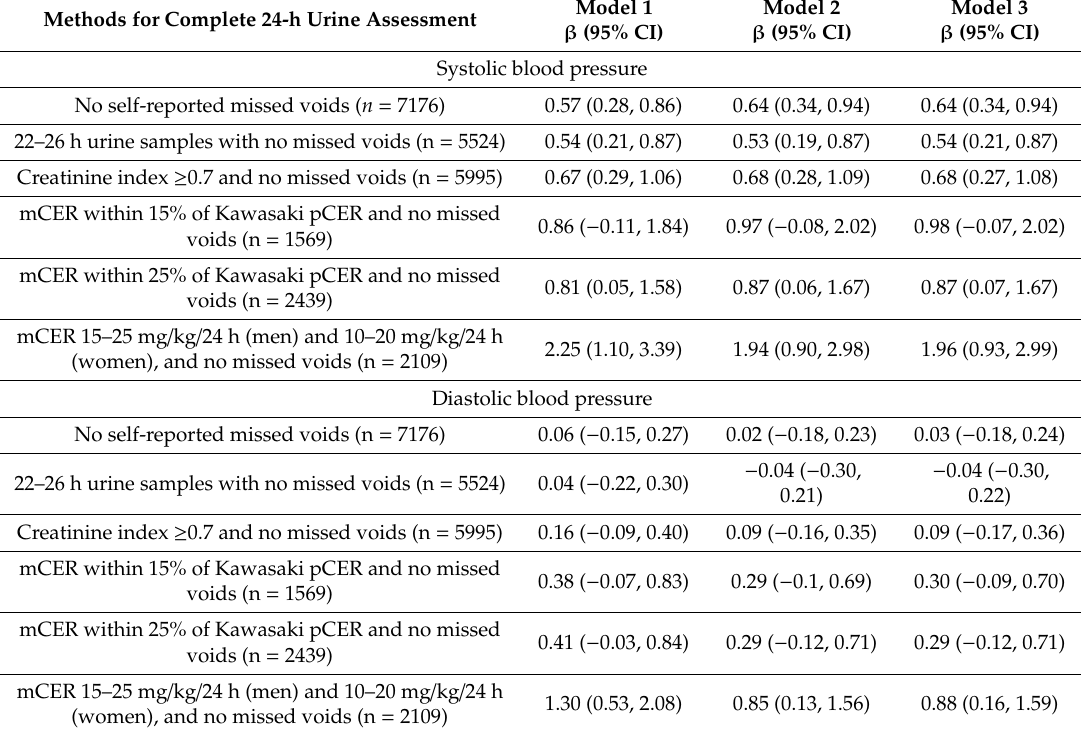
Table 4. Di ff erence in mean systolic BP (mmHg) for 100 mmol or 2300 mg per 24-h increase in 24-h urine